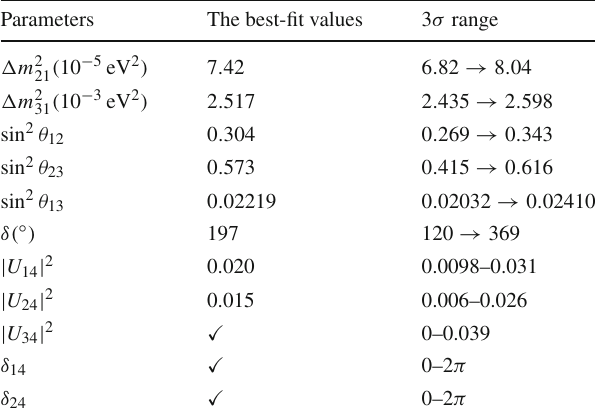
Table1 Theglobalanalysisofneutrinooscillationdatawiththreelight active neutrinos at 3 σ range and the best fit results taken from [1], and one extra sterile neutrino constraints taken from Ref. [10]